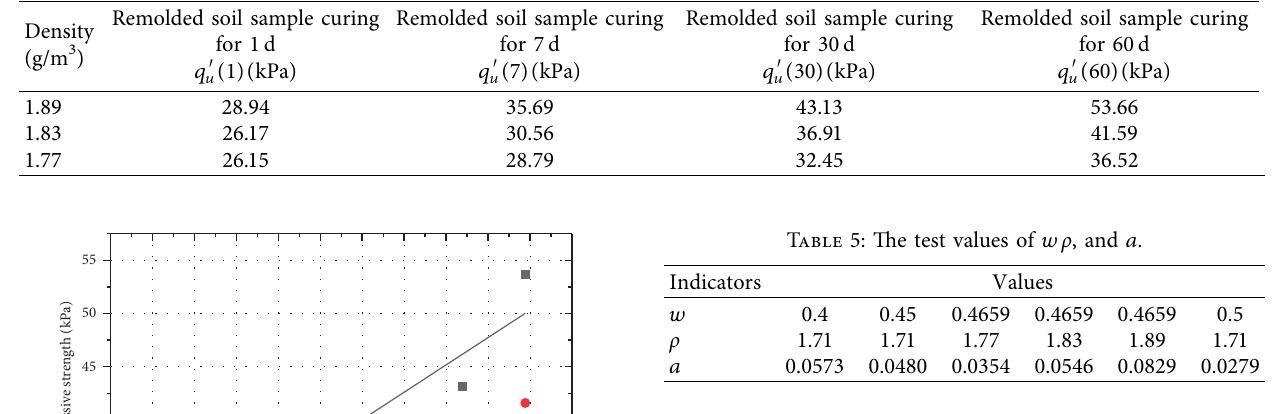
Table 6: Regression statistics.